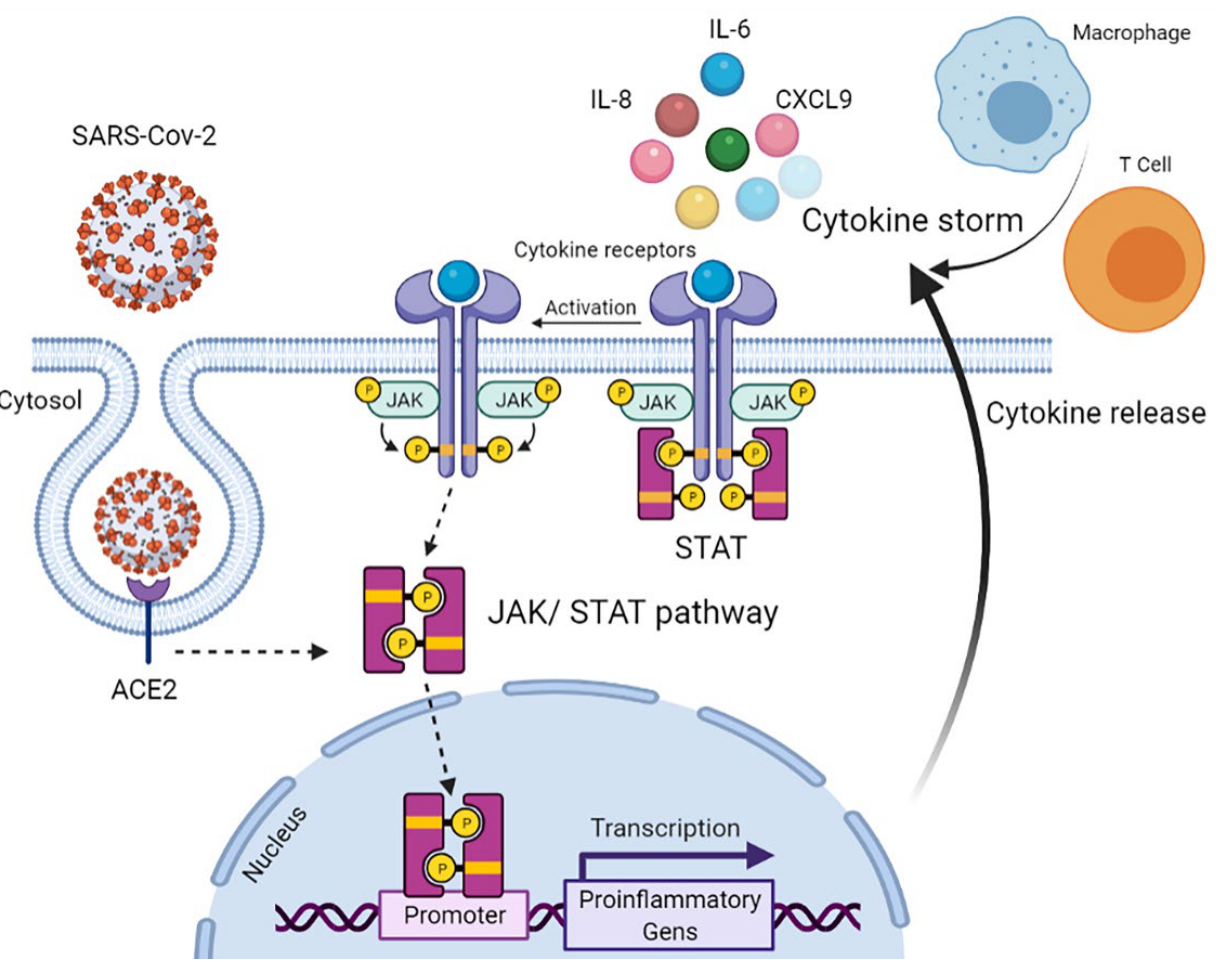
Figure 1. Cytokine release via activation of JAK/STAT signalling pathway following SARS-Cov-2 infection resulting in ARDS related to COVID-19. Abbreviations: ACE2: Angiotensin-converting enzyme 2, CXCL9: Chemokine (C–X–C motif) ligand 9, IL: interleukin, JAK: Janus kinase, and STAT: signal transducer and activator of